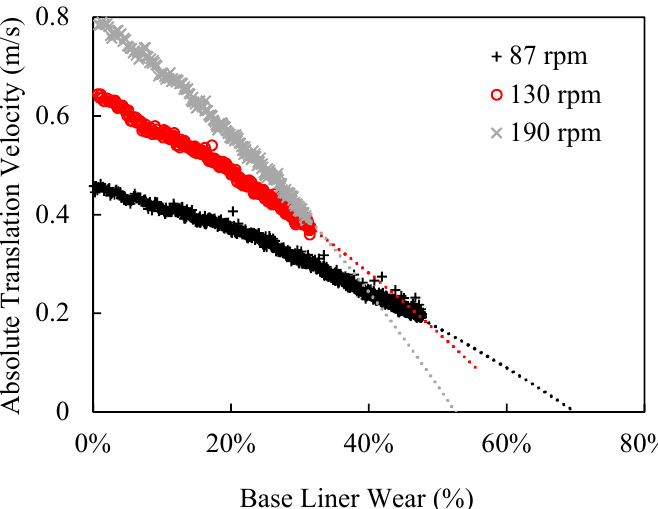
Figure 15. The relationship between average particle velocity and the base liner wear intensity.